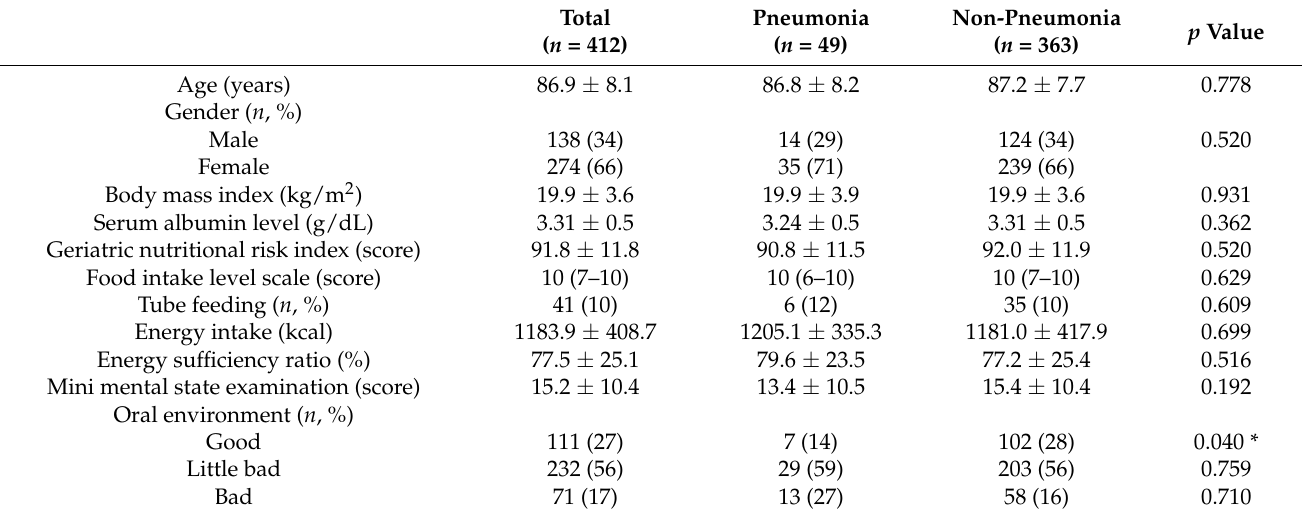
Table 1. Participant characteristics and comparison between